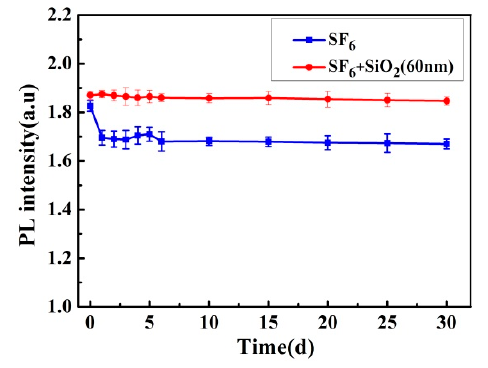
Figure 9. The stability of GaAs PL intensity in open air.